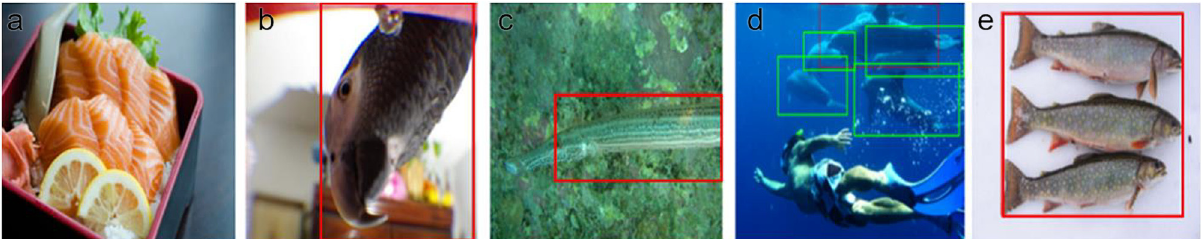
Fig. 5. Types of undesired images and annotations in the Open Image Dataset. (a) Fish processed as food; (b) wrong label (something that is not a fish but labeled as a fish); (c) wrong bounding box alignment; (d) wrong label and missing bounding boxes (original box in black and added bounding boxes in green); (e) individuals grouped as one